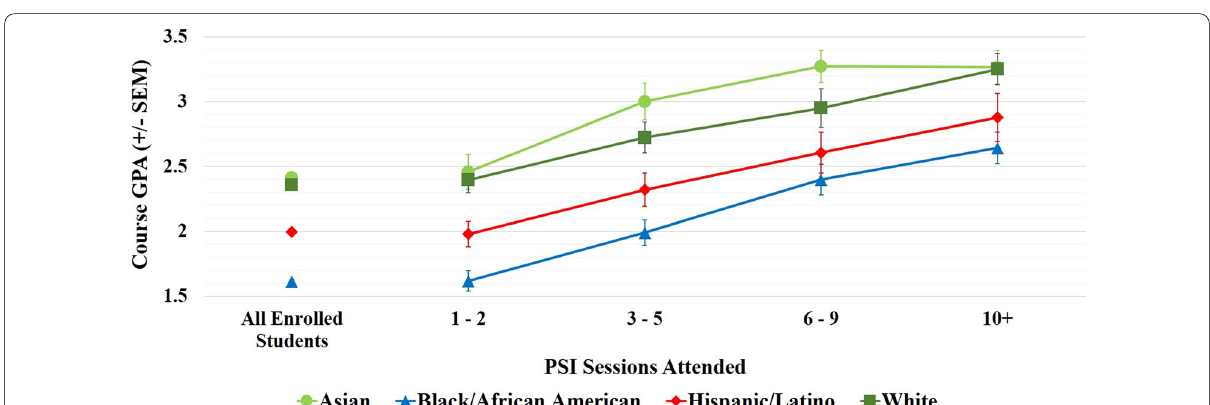
Fig. 5 Mean final course GPAs of PSI participants ( N ( N 18,590), for students identifying with the four racial/ethnic groups studied here. Points are aggregate means = from nine foundation courses over 5